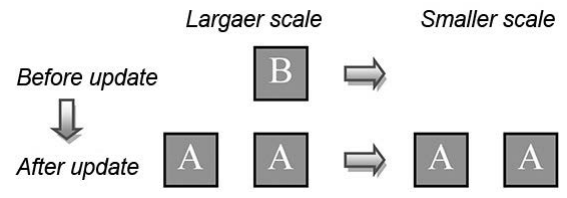
Fig. 2. Cases of creating a new feature